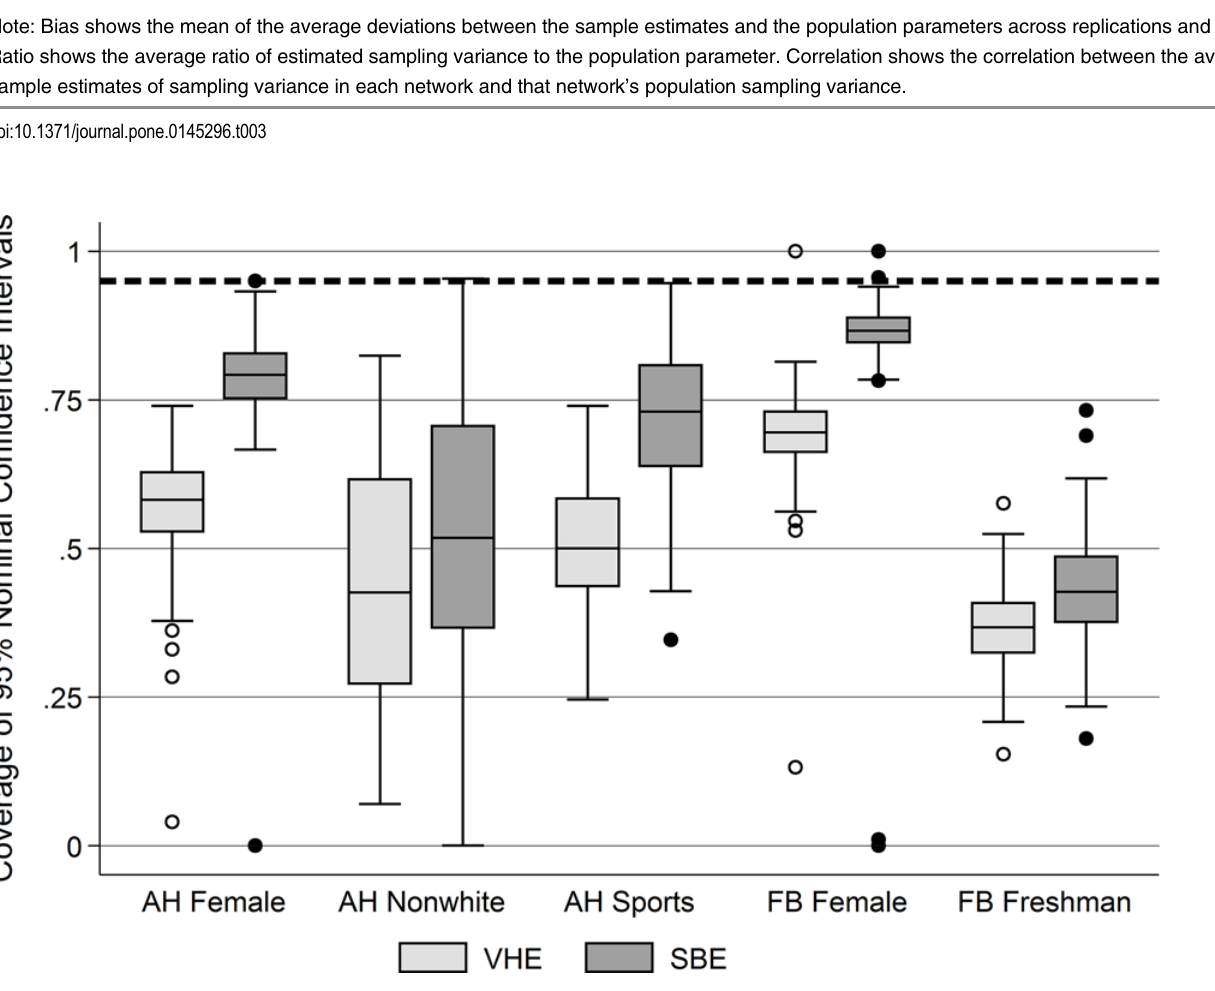
Fig 3. Distribution across networks of coverage rates based on the VHE and SBE estimators, by variable and data set. Note: The expected coverage rate across networks for SRS is .95 (thick dashed line). AH indicates Add Health data set; FB indicates Facebook 100 data set. VHE indicates the Volz- Heckathorn Estimator, and SBE indicates the Salganik Bootstrap